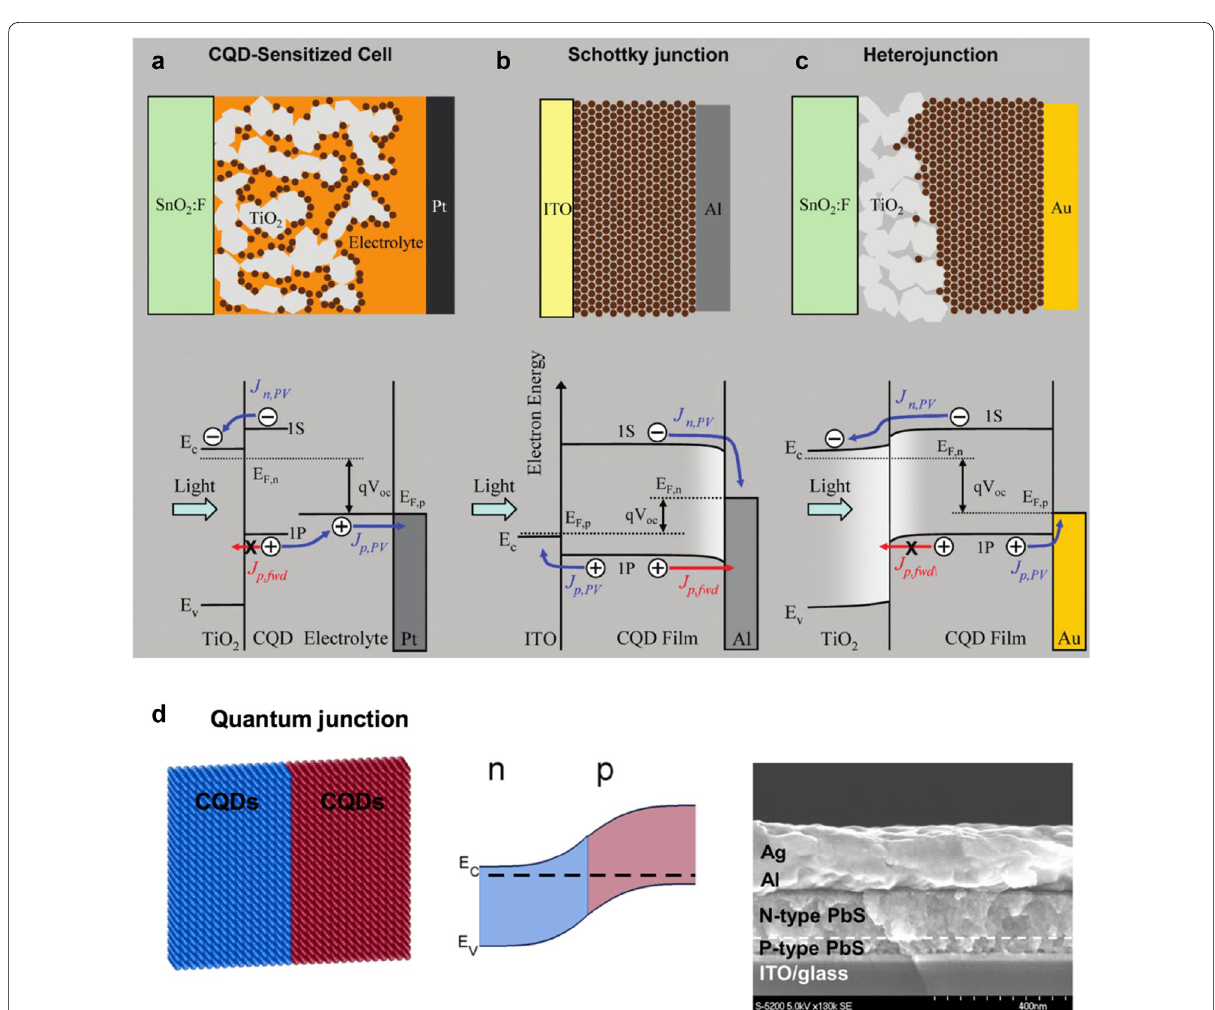
Fig. 3 Schematic of photovoltaic architectures and flat-band diagrams at V OC of a CQD-sensitized solar cell, b Schottky junction solar cell, and c heterojunction solar cell (reprinted with permission from ref. [13], Copyright 2010 American Chemical Society). d Schematic of CQD homojunc- tion solar cell, energy band diagram, and cross-sectional image of scanning electron microscope image (reprinted with permission from ref. [19], Copyright 2012 American Chemical